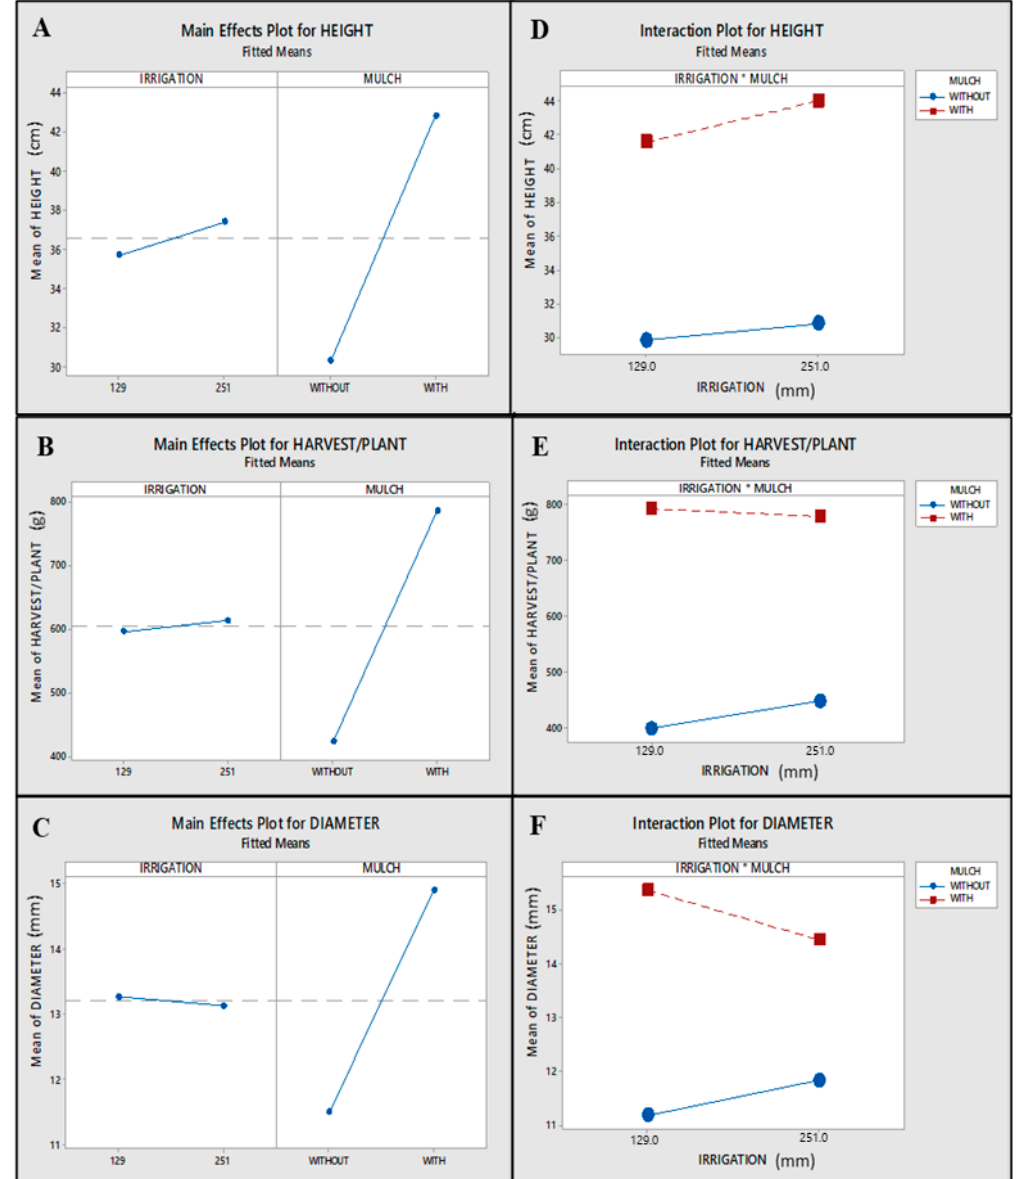
Figure 3. Effects of irrigation regime and mulch application on ( A ) height of pepper plants, ( B ) harvest/plant, and ( C ) basal diameter. Effect plot interaction between irrigation regime and mulch application measured on ( D ) height of peppers plants, ( E ) harvest/plant, and ( F ) basal diameter.